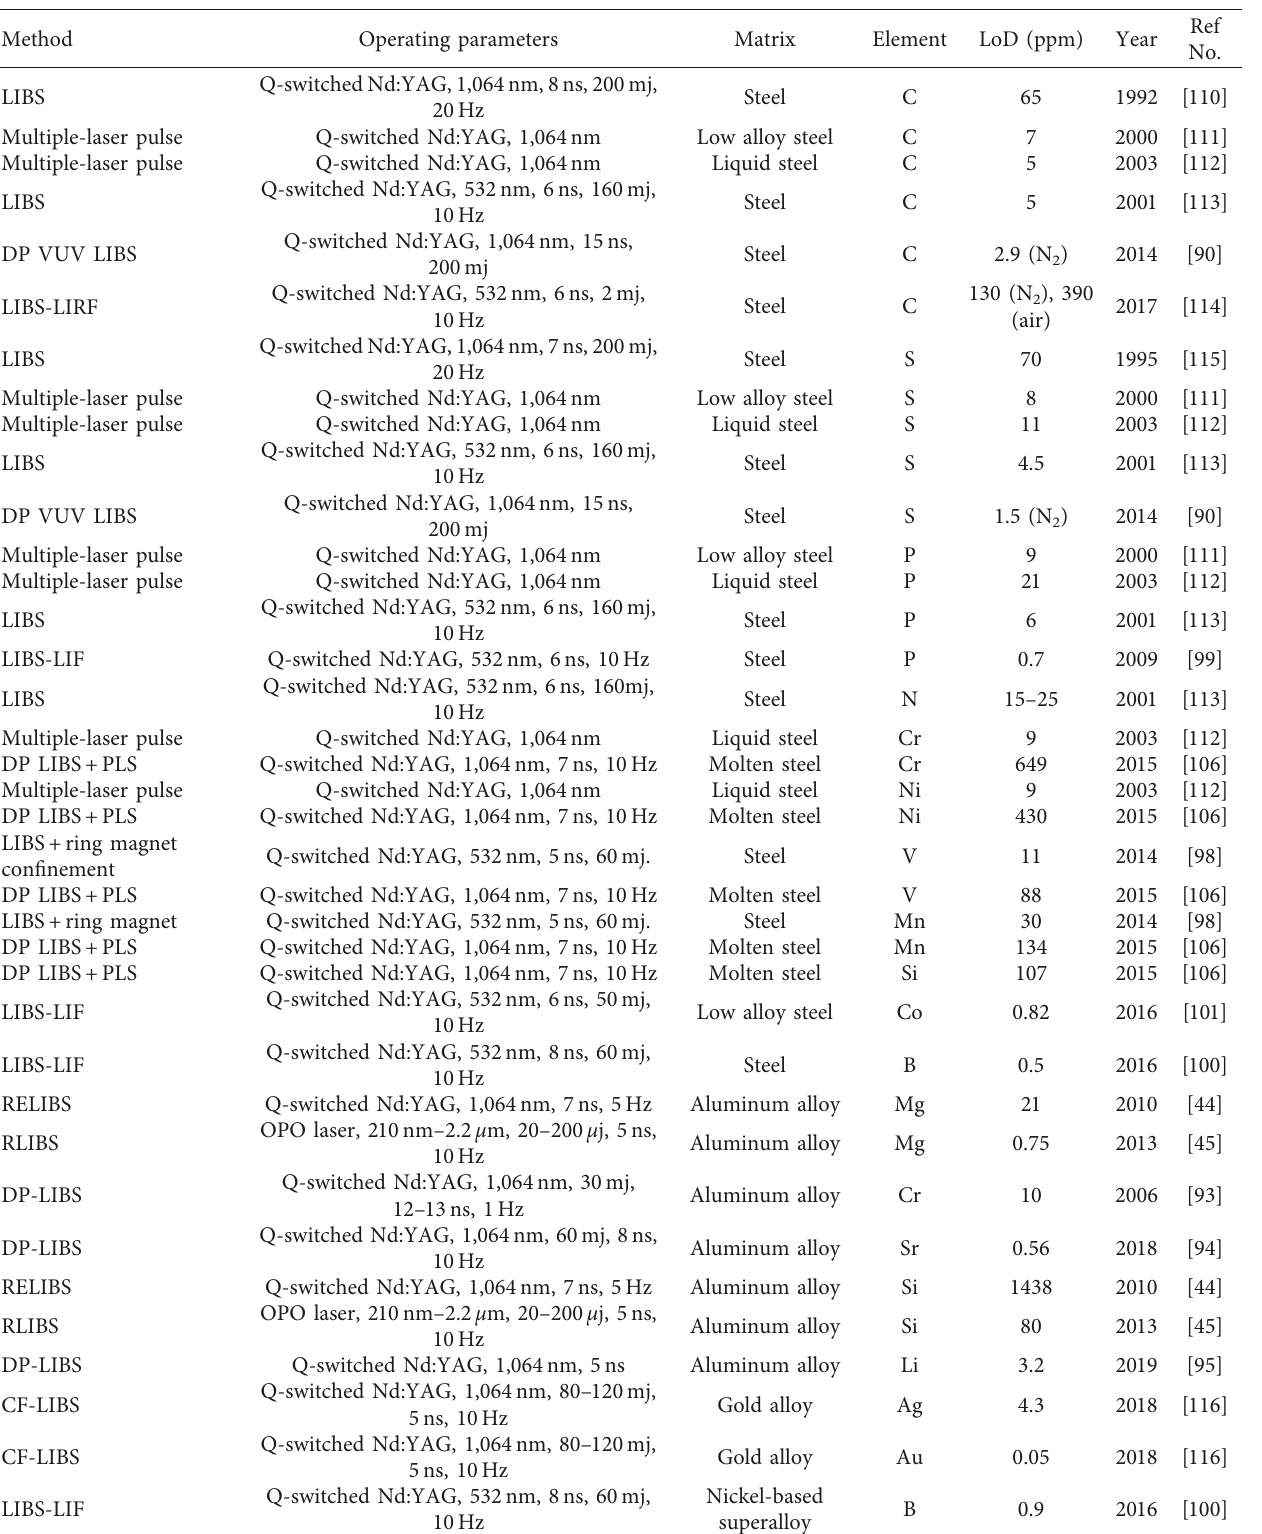
Table 2: LIBS characterization of the trace elements in different ferrous and nonferrous metals.